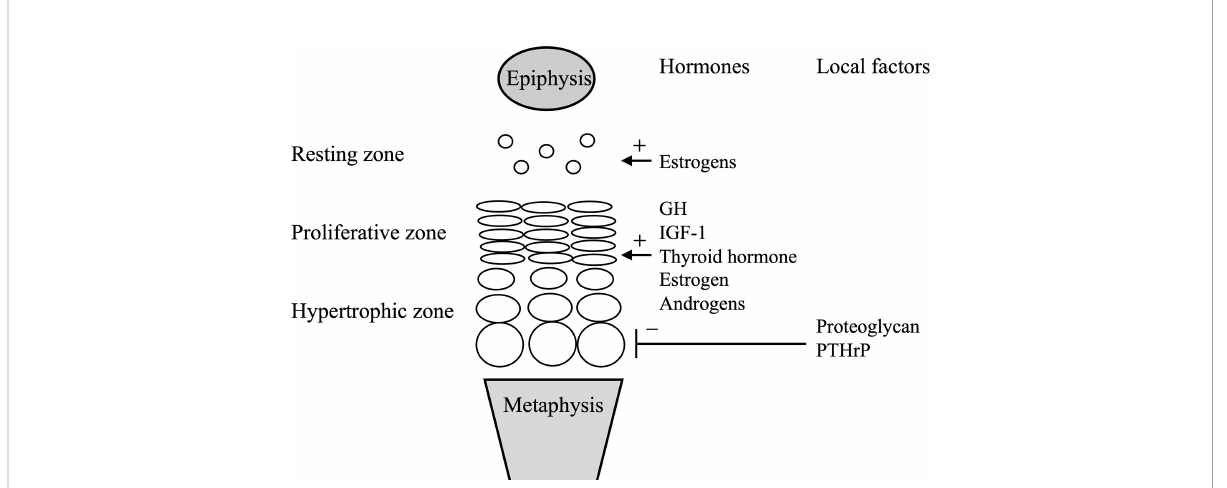
FIGURE 2 Simpli fi ed scheme of the growth plate. Systemic and local factors described in the manuscript are only shown. GH, growth hormone; IGF-1, insulin-like growth hormone-1; PTHrP, parathyroid hormone-related